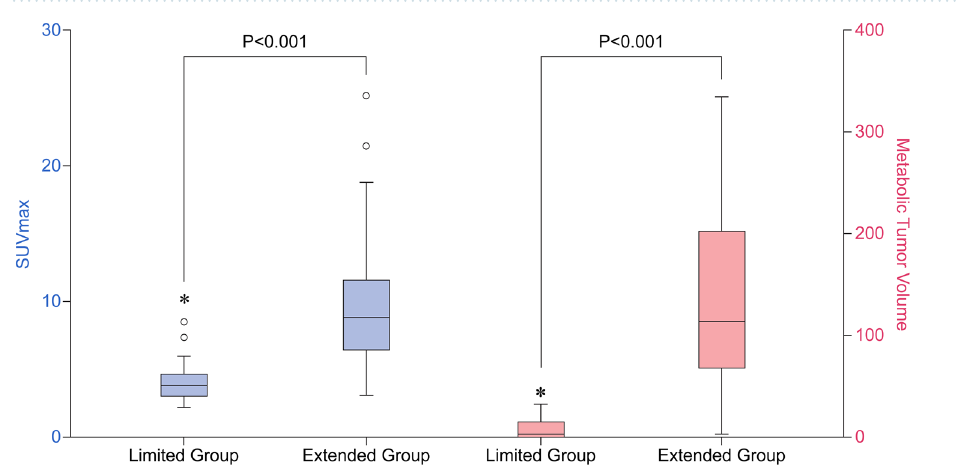
Figure 2. SUV max and metabolic tumour volume differed significantly between limited and extended groups (circles outliers, > 1.5 times interquartile range; asterisks extreme outliers, > 3 times interquartile